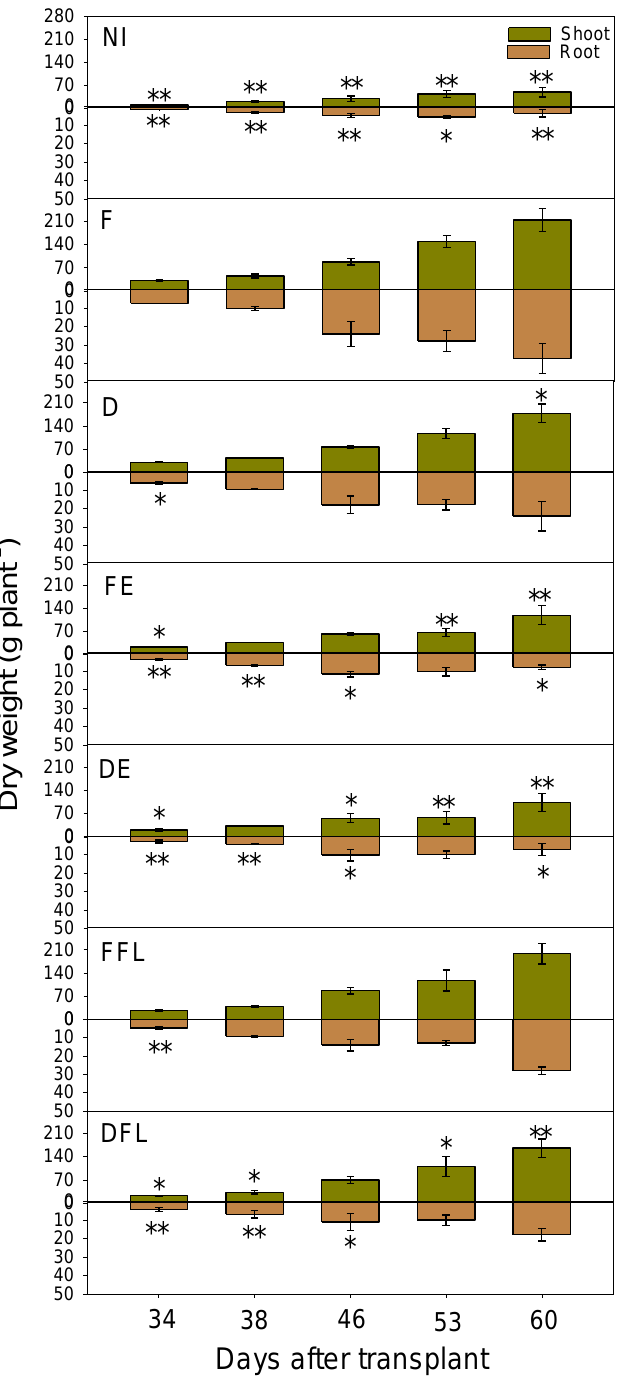
Figure 6. Course of shoot and root dry biomass accumulations (g plant −1 ) during the growth period in processing tomatoes cv. Hypeel F1 under different irrigation treatments. Black vertical bars represent the standard error. Asterisks, when present, indicate significance at p ≤ 0.05 (*) and p ≤ 0.01 (**) respective to the corresponding F treatment within each measurement date.